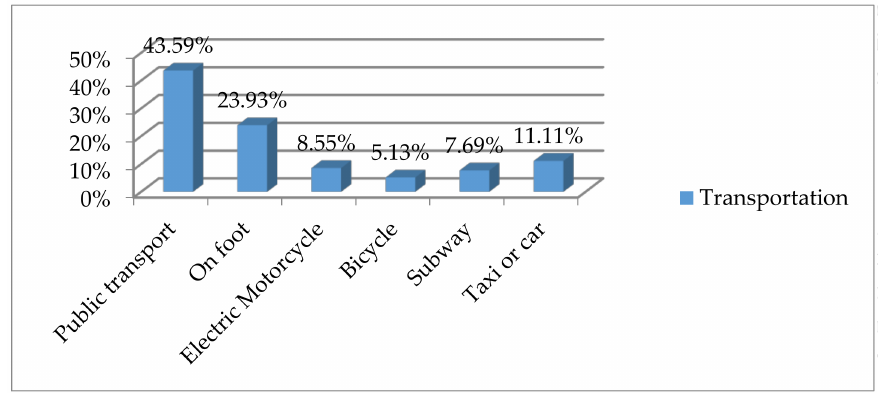
Figure 2. Means of